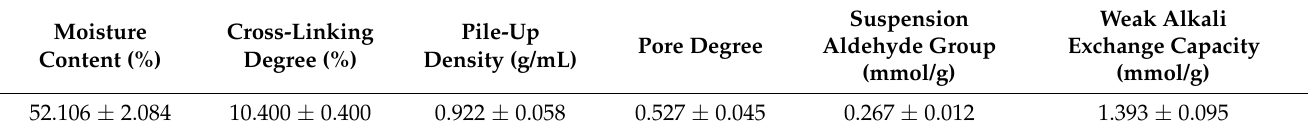
Figure 2. Normal distribution of MRCM particle size. Table 1. Physical properties of